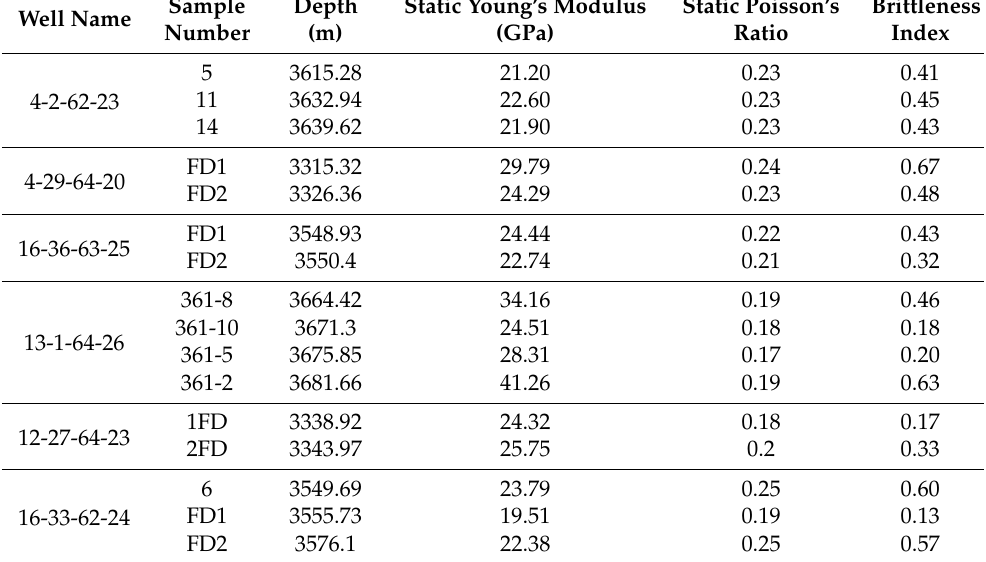
Table 1. Statistics of the geomechanical measurements with vertical direction for coring wells.